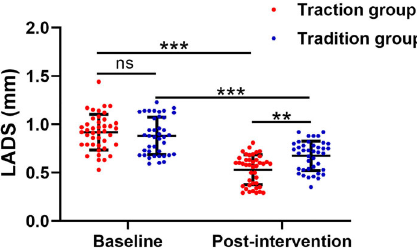
Figure 3. Effects of traction therapy on lateral atlantodental space (LADS) of patients with cervical vertigo due to atlantoaxial joint dislocation. Data are reported as means ± SD and show all data points. **P o 0.01, ***P o 0.001, paired t -test and unpaired t -test. ns: not signi fi cant.